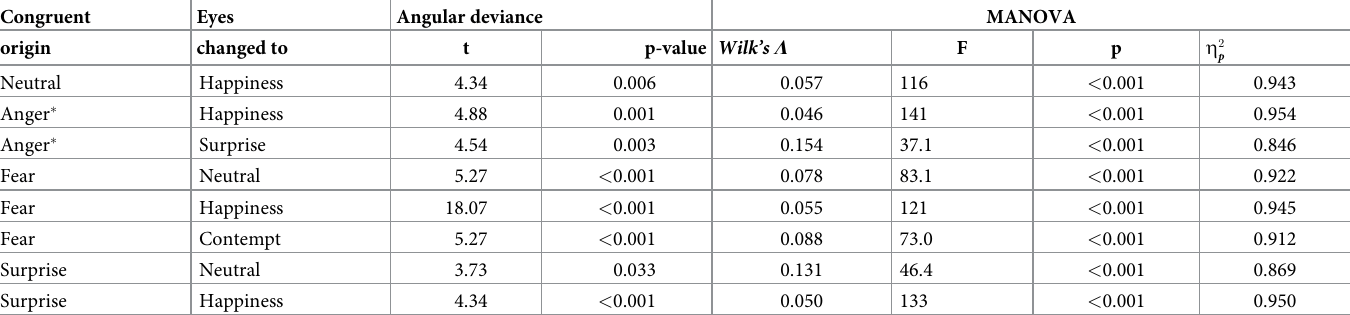
Table 2. Statistical test results of the significant deviations (see asterisks in Fig 3B) caused by changing eye expression from a congruent expression. Bonferroni cor- rection has been applied to all p-values. In MANOVAs, df = 4,27 in conditions marked with � , df = 4,28 in all others. All pairwise differences (post-hoc tests in MANOVAs) are statistically significant (p <